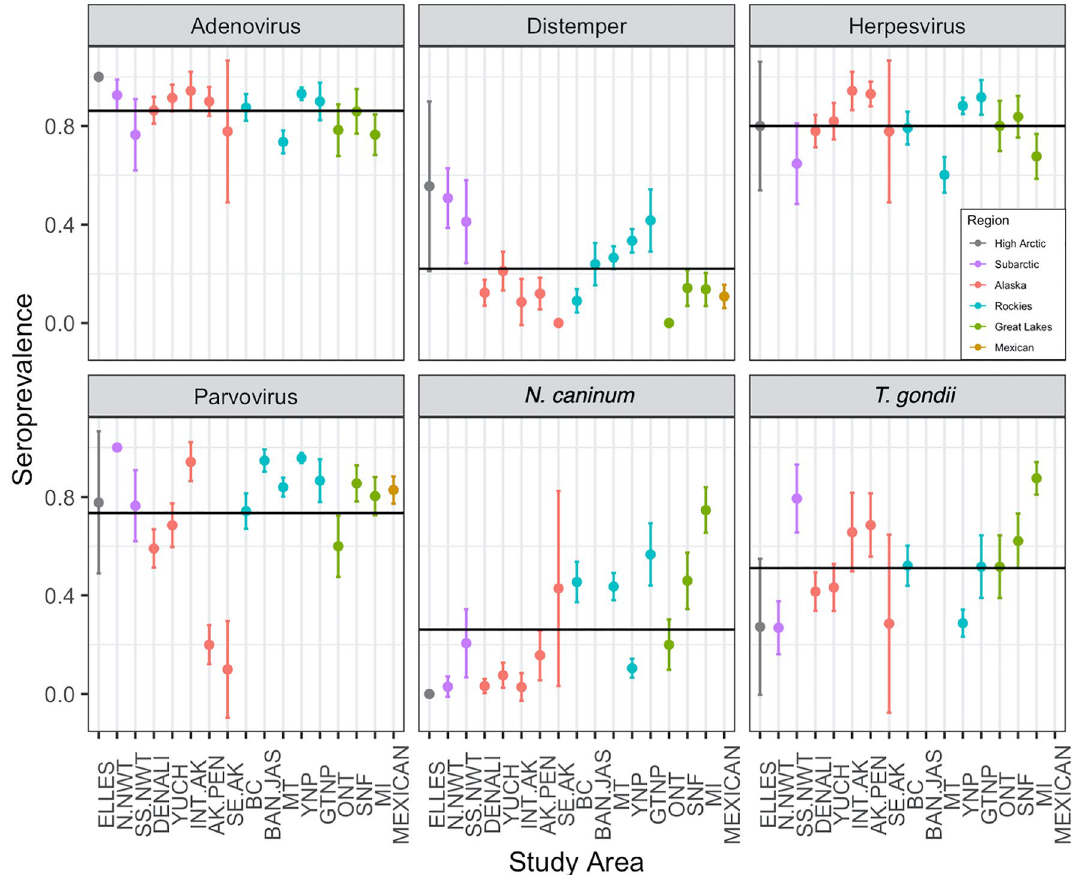
Figure 3. A panel plot displaying seroprevalence estimates, and 95% confidence intervals, for each pathogen tested from each study area 39 . Study areas are listed approximately north (left) to south (right) on the x-axis and grouped by region: High Arctic (gray), Subarctic (purple), Alaska (red), central Rocky Mountains (turquoise), Great Lakes (green), and Mexican (gold) (see Fig. 1 caption for study area abbreviations). The horizontal lines show the grand mean seroprevalence for each pathogen. Note that not all study areas were tested for each probability of pathogen exposure for all pathogens ( β > 0, p ≤ 0.05 except T. gondii ; Fig. 4D). Human density had large effects on distemper, parvovirus, and N. caninum —for example, the probability a wolf was seropositive for distemper increased 68% over the human density range assessed (Supplementary Fig. S9). Similarly, wolf density was positively related to the probability of pathogen exposure for all pathogens (β > 0), except T. gondii (β ~ 0), and was a statistically significant predictor of pathogen exposure for pathogens except parvovirus and T. gondii (Fig. 4E). The effect of pack size on probability of exposure was variable (β < 0 N. caninum, T. gondii; β > 0 adenovi- rus, herpesvirus, parvovirus; β ~ 0 distemper), but these effects were small and statistically insignificant (Fig. 4F). Contrary to our predictions, probability of pathogen exposure was invariant to coat color and sex such that effect sizes were small and statistically insignificant (Fig. 4H,G); the exception was that gray wolves had a slightly higher probability of exposure to N. caninum than black wolves. As expected, seroprevalence increased with age for all pathogens (Fig. 4I,J). See SI Model Results (Supplementary Table S7) for additional modeling outputs. We performed a four-fold cross validation whereby 13 study areas were used as the training set and the remaining four study areas were used as the testing set (Supplementary Fig. S5, Table S6). Testing set RMSE values were higher than RMSE values from models built using the training set, indicating that predictive power was weaker than explanatory power, as expected 72 . This also suggests that model fit was not highly dependent on which study areas were used in the training or testing sets. Geographic models had marginally higher RMSE and lower AUC than complete models , indicating slightly poorer fit and classification power. Regardless of model, exposure to some pathogens was better explained than others (e.g., poorest fit for T. gondii , best fit for adenovirus and herpesvirus). RMSE values were fairly high across all models, meaning that there was a significant amount of variation in pathogen exposure that was unaccounted for—especially T. gondii . This was also evident in that random effects accounted for a notable portion of the variation in pathogen exposure (Fig. 5), and pseudo-R 2 values were fairly low (< 0.4). Models had moderate power to correctly classify an individual as positive or negative for pathogen exposure (mean training set AUC = 0.69, mean testing set AUC = 0.67). For pathogens other than T. gondii , AUC dropped, on average, 2–4% from training to testing sets when evaluating the same pathogen; the training set AUC was,